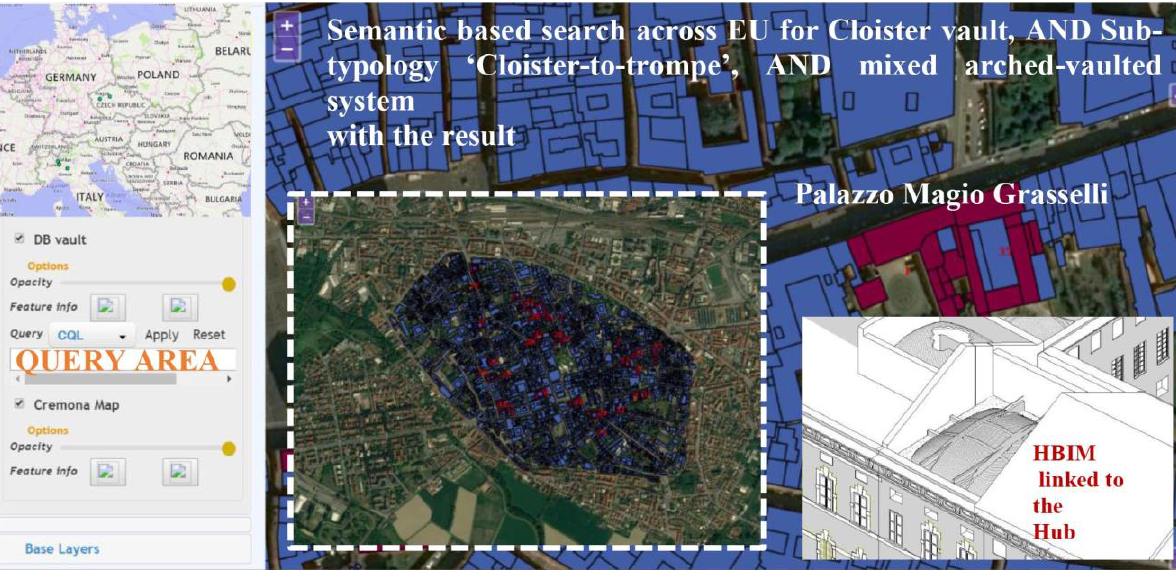
Figure 5. The Vault DB reconstructed form the vaulted system in Cremona. The Palazzo Magio Grasselli and the HBIM linked to the Hub Platform , the Manfredini Hall with the mixed arch and vaulted system